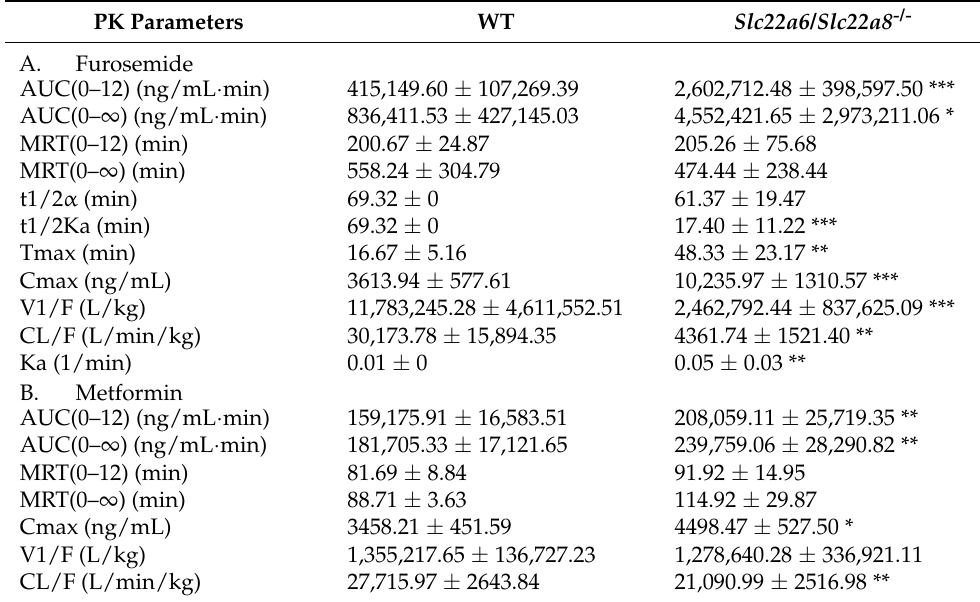
Figure 7. Effects of Slc22a6/Slc22a8 double-knockout on the pharmacokinetics and urinary excretions of the anionic drug furosemide and the cationic drug metformin. ( A ) Plasma concentration-time curve of furosemide (n = 6). ( B ) Cumulative urinary excretion-time curve of furosemide (n = 7). ( C ) Plasma concentration-time curve of metformin (n = 5). ( D ) Cumulative urinary excretion-time curve of metformin (n = 6). Data are presented as mean ± SD. *, p < 0.05; **, p < 0.01; ***, p < 0.001 compared with WT rats. Table 3. Pharmacokinetic parameters of furosemide and metformin after administration in rats.